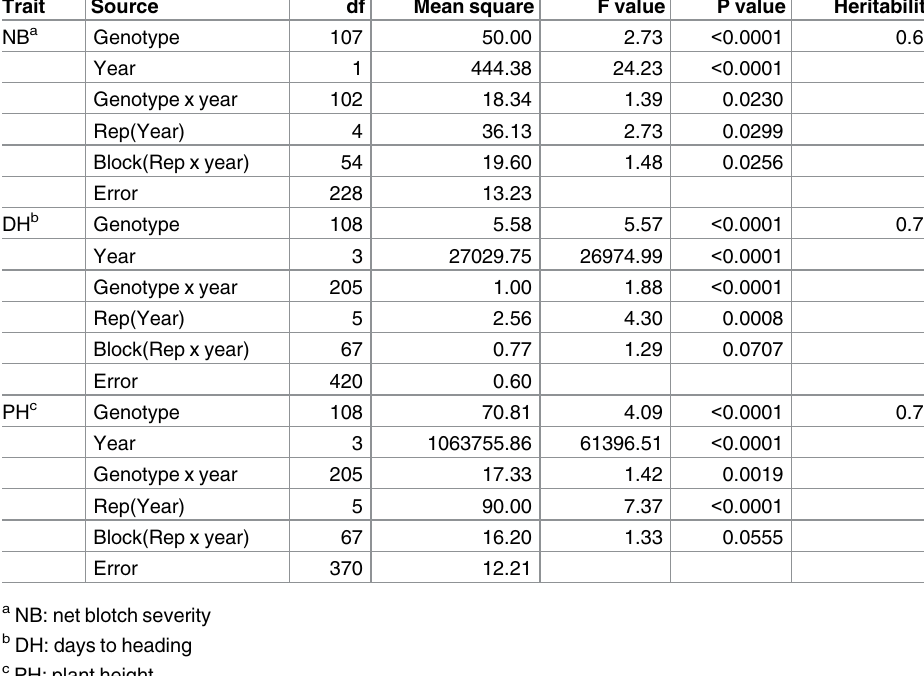
Table 2. Analysis of variancetable for net blotch severity(NB), days to heading (DH) and plant height (PH) and heritabilities in the AxL mapping population.